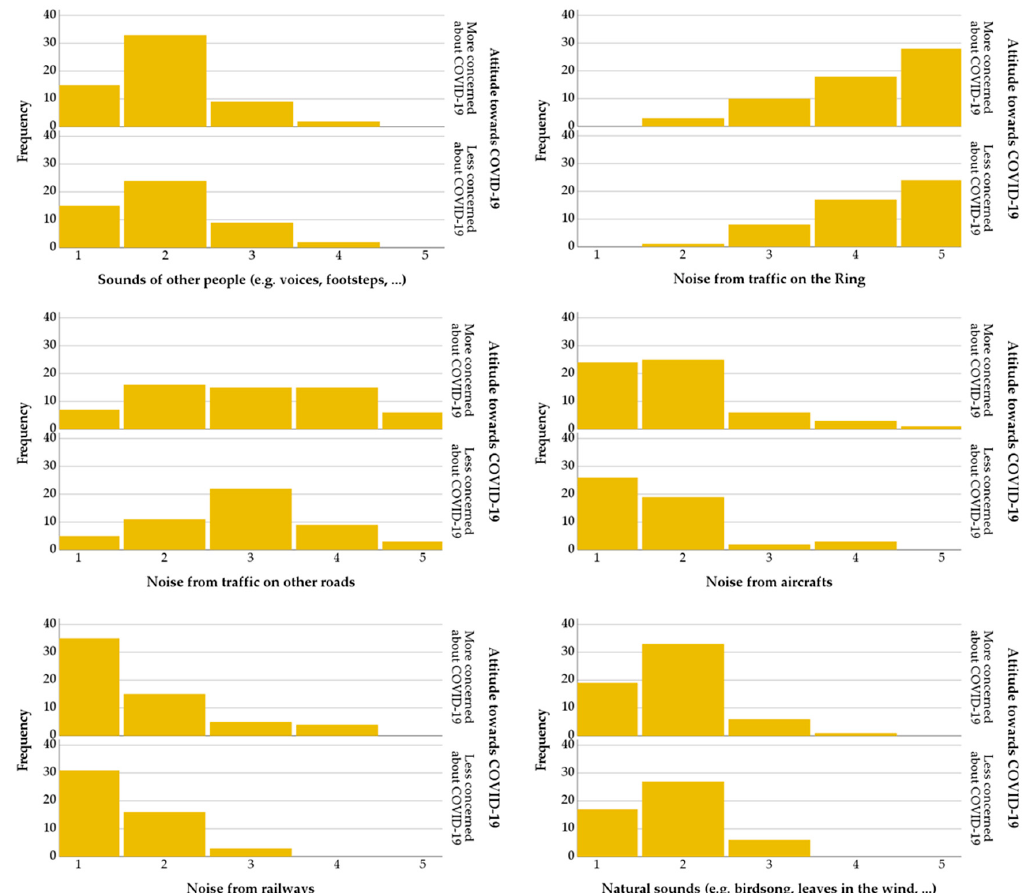
Figure 5. Distributions of the scores for the items of category (c) of the questionnaire (i.e., “Noticed sounds”), each split according to the ATC19 variable groups.